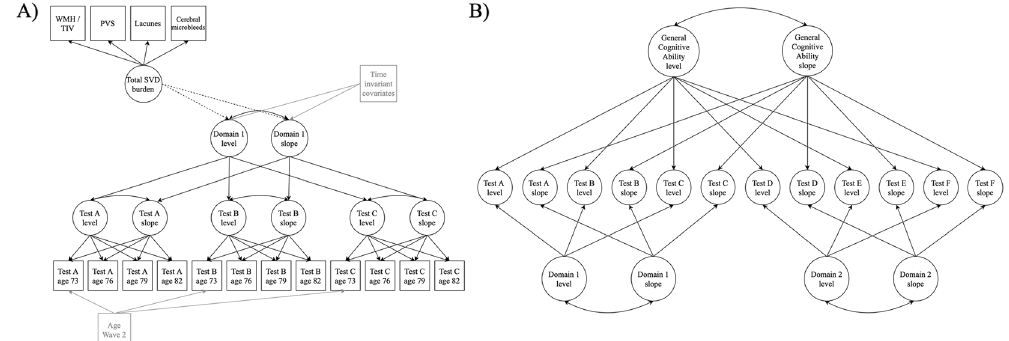
Fig. 3 Illustrations of a hierarchical ‘ factor-of-curves ’ model and a longitudinal bifactor model of cognitive ability. A Example of a hierarchical ‘ Factor-of-Curves ’ (FoC) model of cognitive ability. For the hierarchical FoC models, a growth curve was estimated for each individual cognitive test, producing a latent intercept and slope. These test-speci fi c latent intercepts and slopes, in turn, loaded onto an overall latent intercept and slope for the cognitive domain. Loadings on the slopes were set to 0, 3.78, 6.83, and 9.55, to re fl ect the average time lags between baseline and subsequent waves. In this illustration we also show how we speci fi ed associations between latent SVD burden and the intercept and slope of the cognitive factor (see dashed lines), and how we included additional time-invariant (sex, vascular risk, childhood cognitive ability) and time-variant (age) covariates (see items in grey). Separate models were carried out for each cognitive domain (i.e. general cognitive ability, processing speed, verbal memory, and visuospatial ability). Following conventional SEM notation, variables in squares were observed and measured, and variables in circles represent unobserved latent variables. Single headed arrows represent speci fi ed relationships between variables and double headed arrows represent correlations. B Example of a longitudinal bifactor model of cognitive ability. In the centre of the model are the latent intercept and slope of each cognitive test, which were constructed using latent growth curves of the originally observed test scores at each time point (as described in the panel A note). The variance in these test-speci fi c latent intercepts and slopes is separated into that which contributes to the latent intercept and slope of each cognitive domain, and that which contributes to the latent intercept and slope of general cognitive ability. We tested associations between total SVD burden and the intercept and slope of each cognitive variable simultaneously (not shown in this illustration). Additional time-invariant and time-variant covariates were included as indicated for the hierarchical FoC model (not shown in this illustration, see panel A for